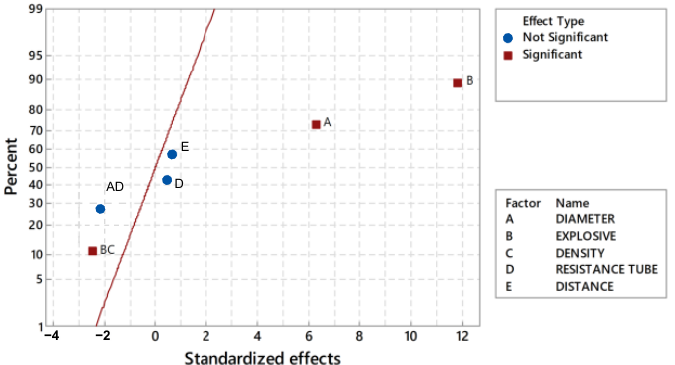
Figure 11. Normal graph of standardized effects for a significance level α = 0.05. Commented [M1]: Please explain the meaning of